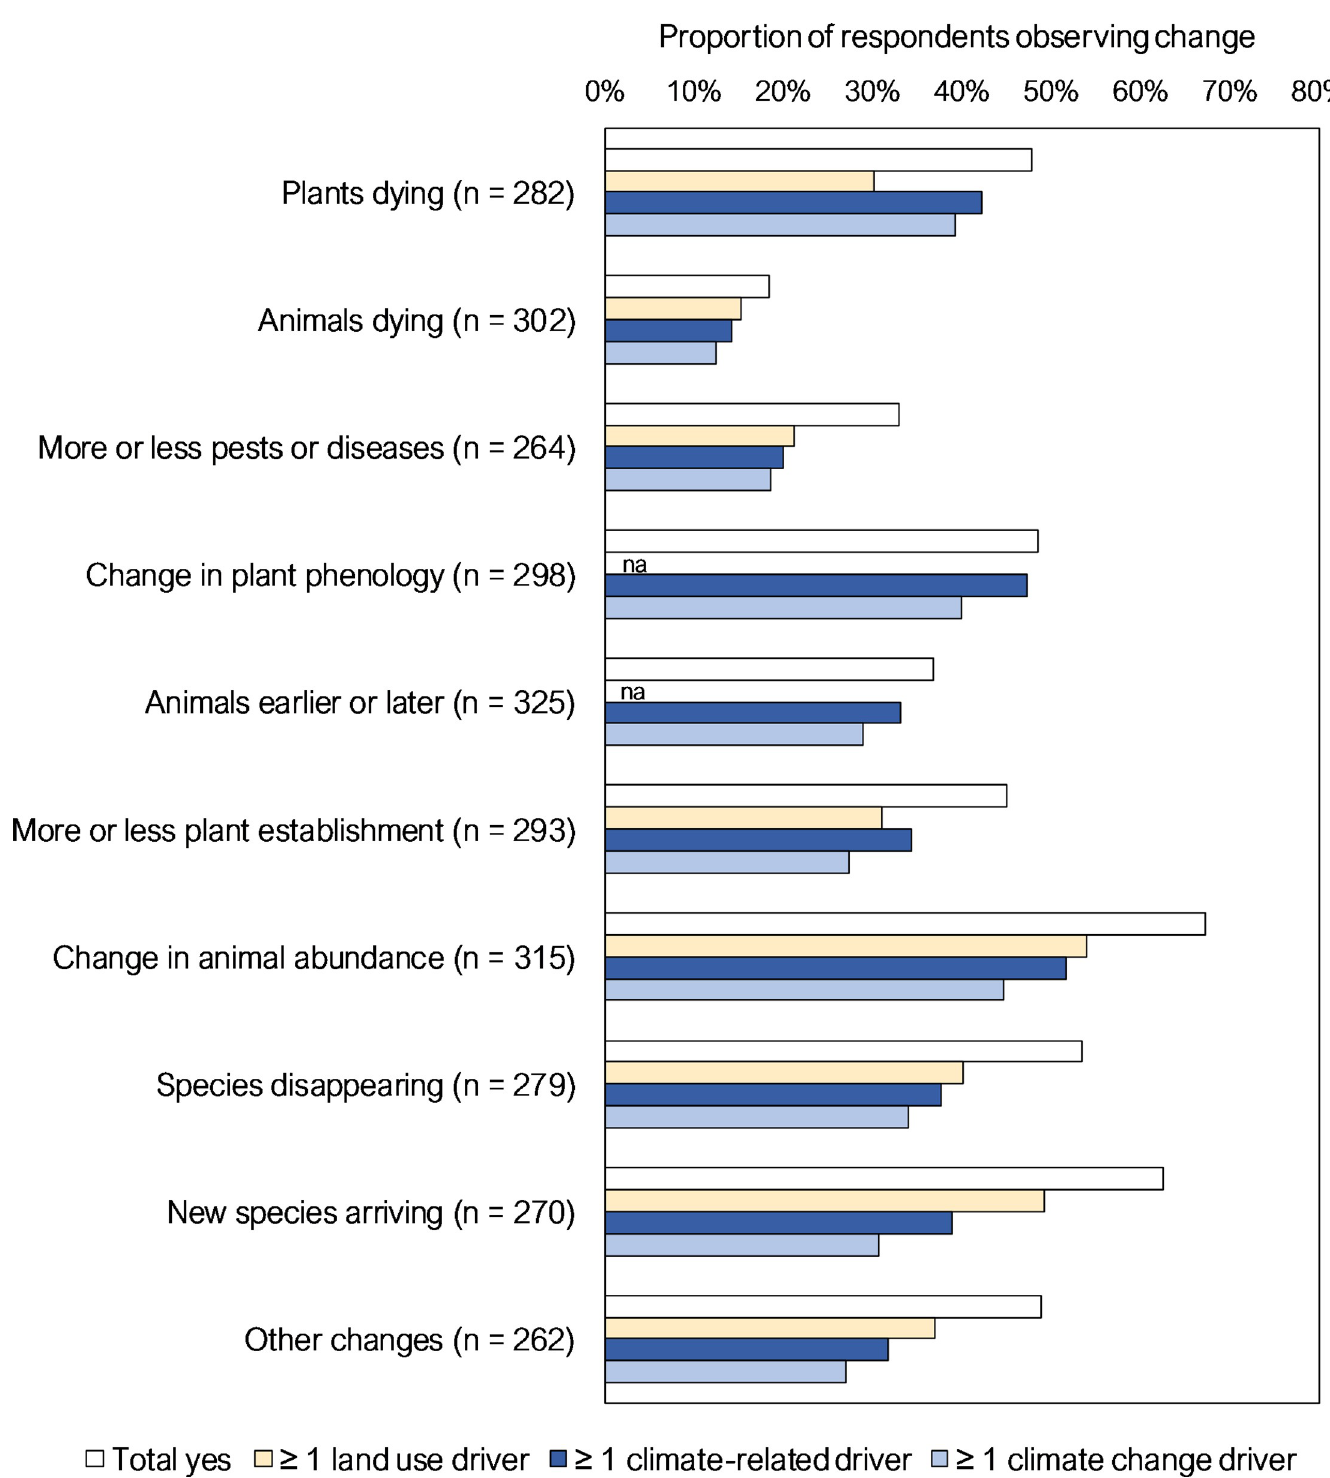
Fig 3. Proportion of respondents observing each of the ten investigated types of change. Refers to Part 1 multiple-choice questions, and includes proportion for each with attribution by respondents to land use, climate and climate change drivers. For summary purposes, ‘potentially climate-change related’ includes climate drivers scored by respondents as ‘unprecedented’ or as ‘climate-change-related’ (break down into those two groups is shown in S2 Appendix: Figure C).